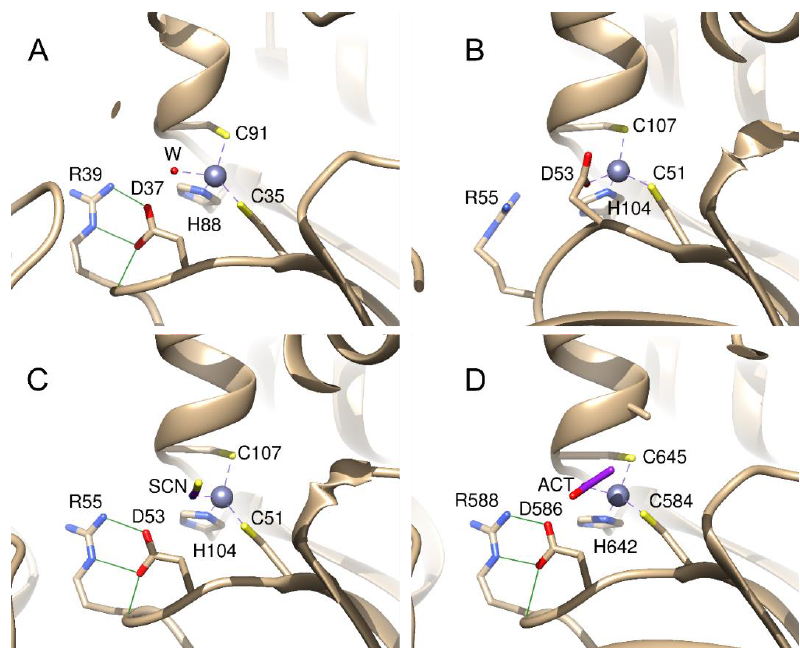
Figure 7. The active site of Mtb β -CAs. ( A ) Rv1284, PDB ID: 1YLK, ( B ) open conformation of Rv3588c, PDB ID: 1YM3, ( C ) closed conformation of Rv3588c, PDB ID: 2A5V, ( D ) homology model of Rv3273